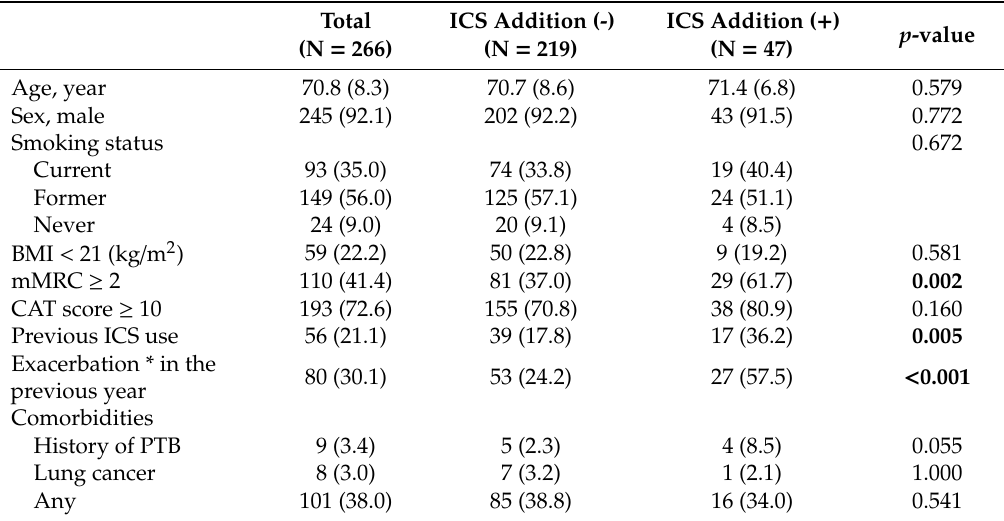
Table 1. Baseline characteristics of 266 patients according to ICS addition after LAMA / LABA fixed-dose combinations